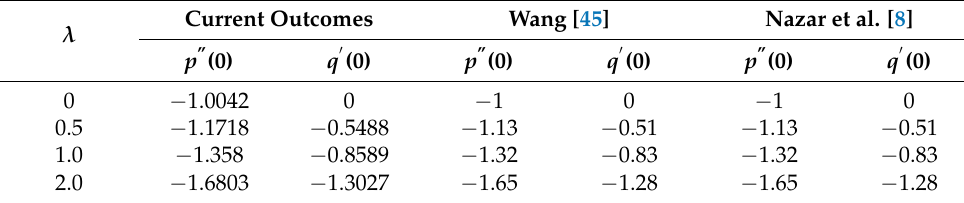
Table 2. For specific situations, the present results are compared to prior research.